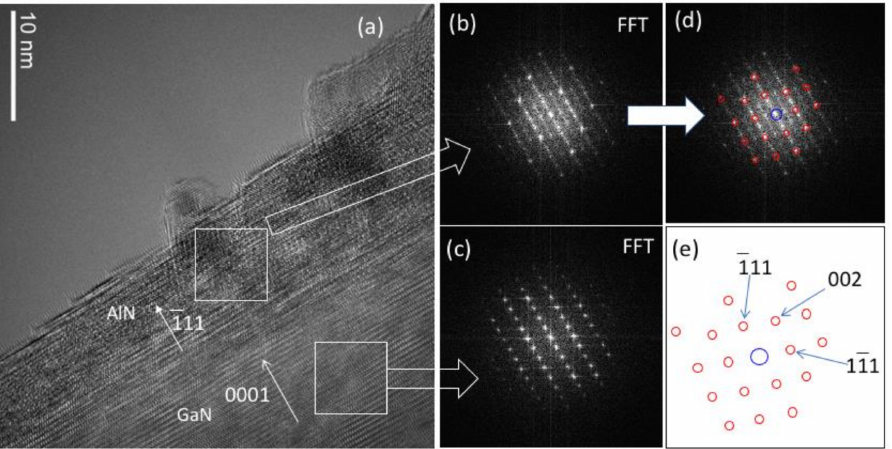
Figure 6. ( a ) HRTEM image showing the AlN layer grown on (0001) GaN. ( b ) FFT from AlN layer, ( c ) FFT from GaN, ( d ) FFT showing the encircled spots in [110] zone of zinc blend AlN, ( e ) The indexed pattern in [110]